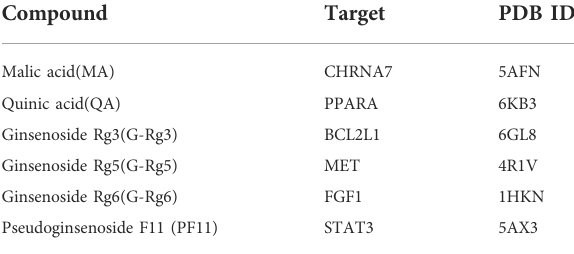
TABLE 5 Information of the compounds docking